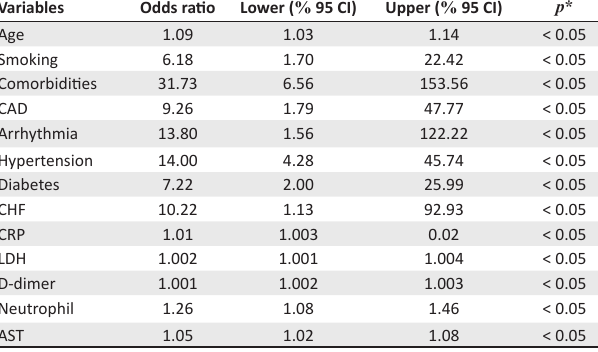
TABLE 5: Factors related with mortality.